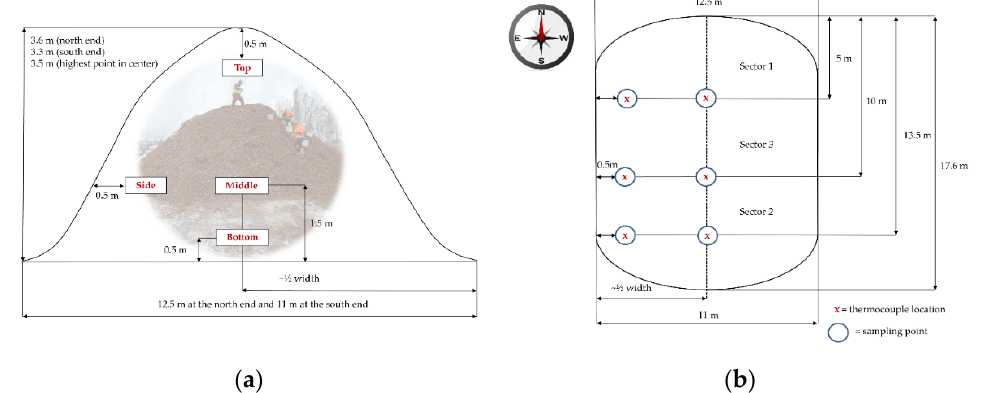
Figure 17. Schematic representations of the measures of the bark pile and ( a ) the thermocouple locations inside the bark pile and ( b ) the sampling points and sectors.